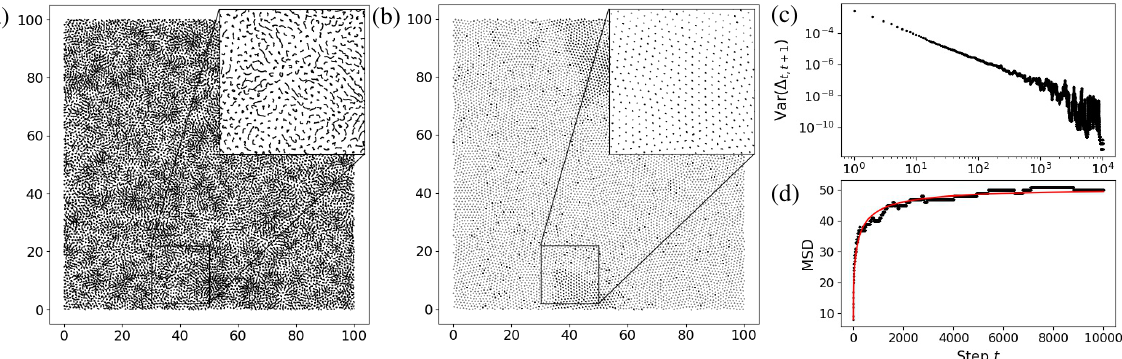
Figure 1: Trajectory plots of N = 10 4 points in a square system of Poisson-PP within step ranges (a) [1 , 100] and (b) [7000 , 8000] of the Lloyd iterations. (c) Decay of variance of displacements measured for the same realisation as in (a-b). (d) The mean square displacement along the course of Lloyd iterations, averaged over di ff erent realisations of Poisson-PP (black), which is then fitted by a stretched exponential curve